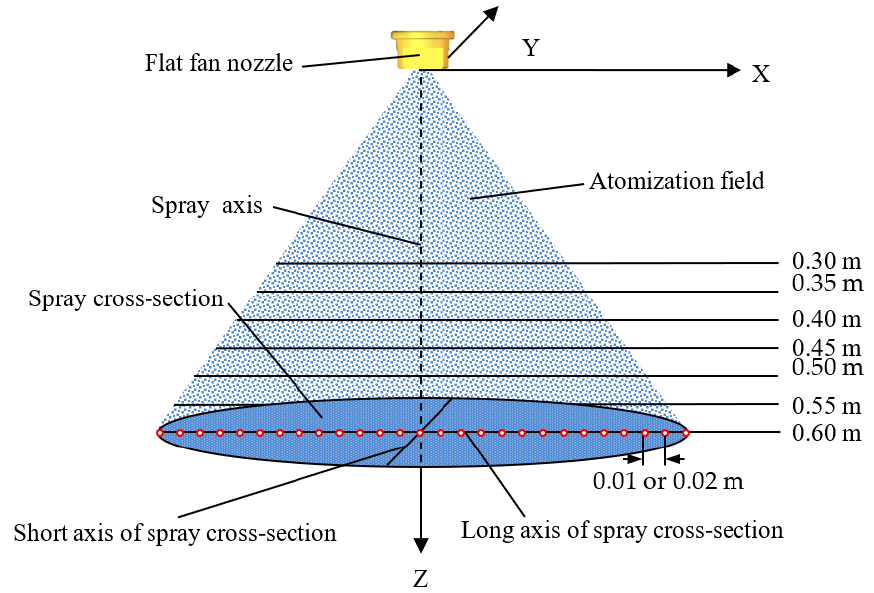
Figure 3. Field of flat fan nozzles. The small red circles represent the measurement point.